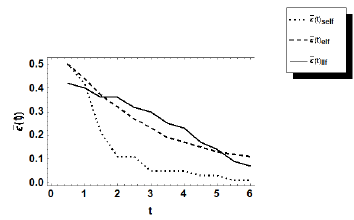
Figure 2 – When c = 1 and h = 1, the MSE of (cid:69) ( t ) using important sampling procedure.